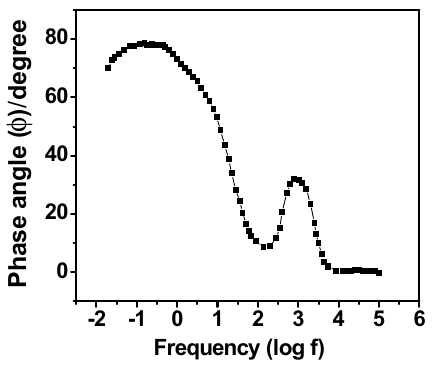
Fig. 8 Nyquist plot of SnO (SnO